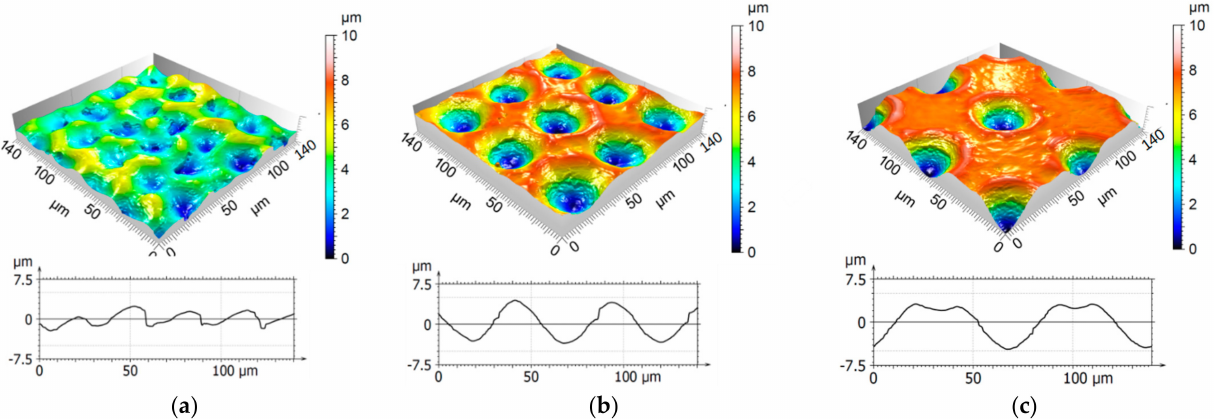
Figure 6. Confocal images and corresponding profiles of stainless steel surfaces micropatterned with 500 pulses with a pulse duration of 200 ns and a fluence of 0.44 J/cm 2 . The DLW spot distance was set to ( a ) 30 µ m, ( b ) 50 µ m, and ( c ) 70 µ m.